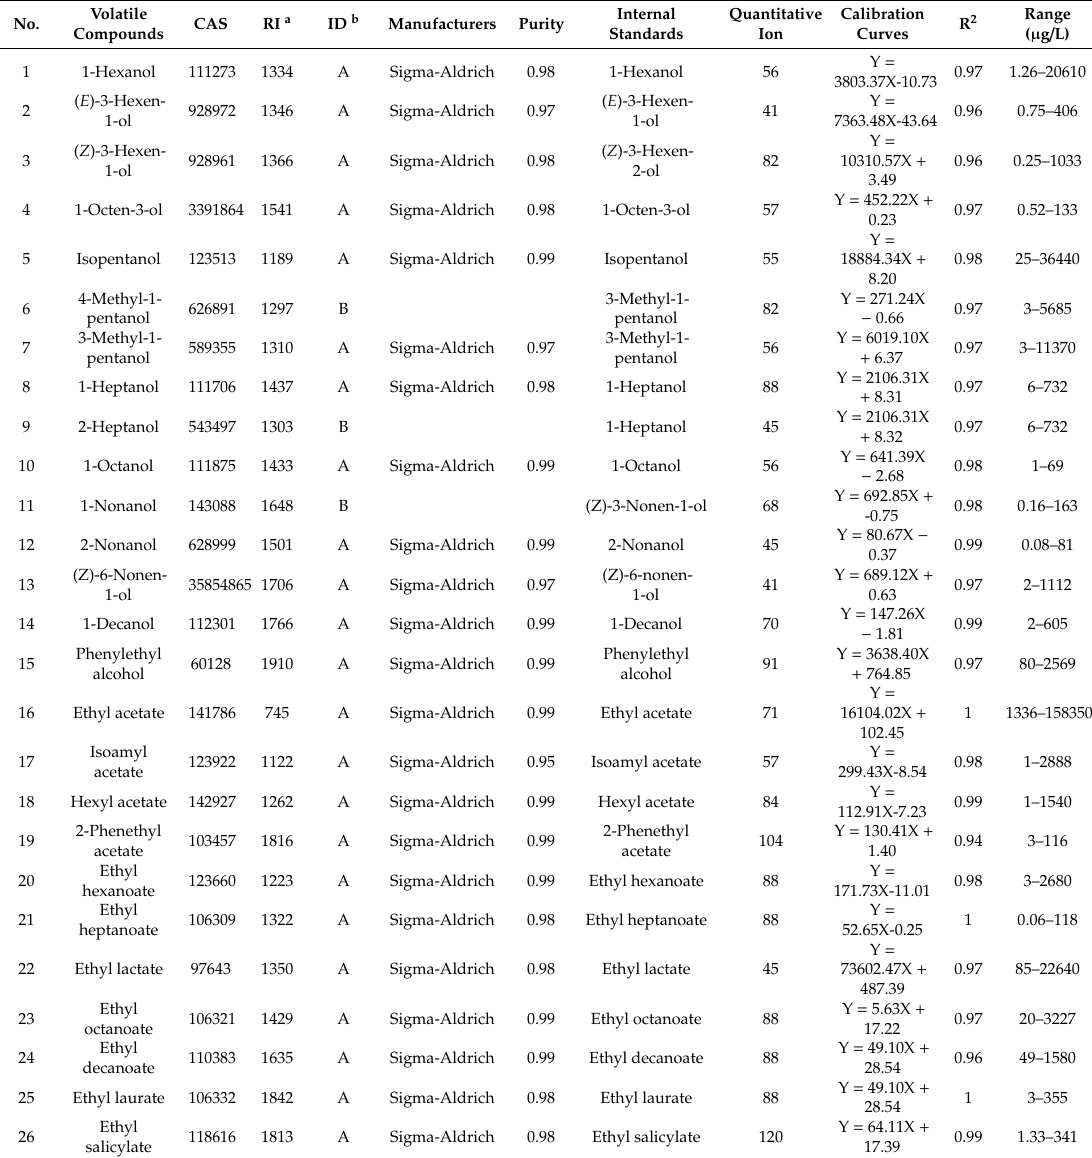
Table 5. Calibration parameters (Chemical Abstracts Service Number (CASN), Retention Indices (RI), Identification (ID), Manufactures, Purity, Internal standards, Quantitative ion), calibration curves’ linear correlation coe ffi cients (R 2 ), and range for the quantitative analysis of volatile aroma compounds